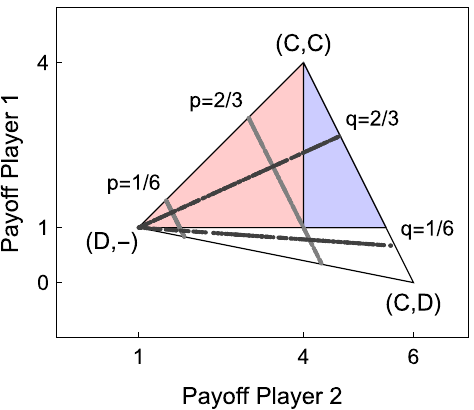
Figure 7. Players’ strategies in the payoff space. For each player, we fixed an unconditional strategy, and we let it play with 1000 randomly generated memory one strategies. Black dots are possible payoffs profiles when Player 2 sets q = 2 3 or q = 1 6 . Gray dots are payoff profiles when Player 1 sets p = 2 3 or p = 1 6